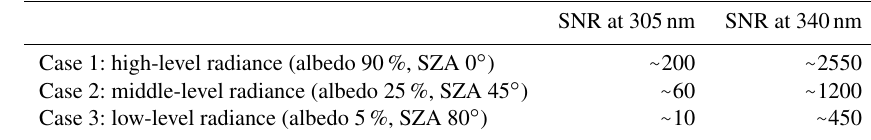
Table 2. Estimation of three reference SNR values in the UV